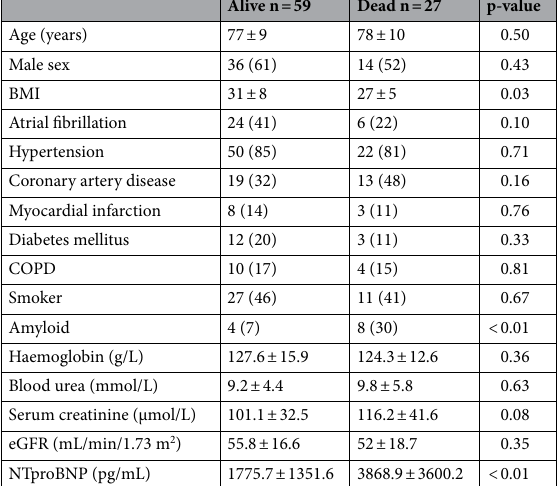
Table 1. Study demographics.